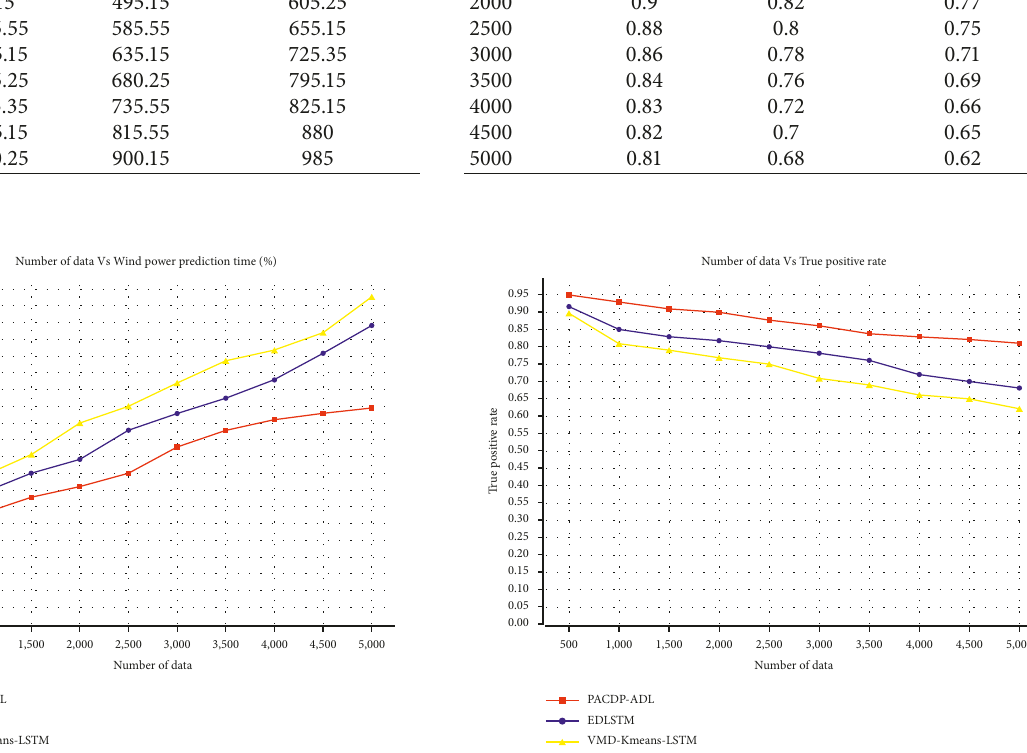
Figure 6: Graphical representation of true positive